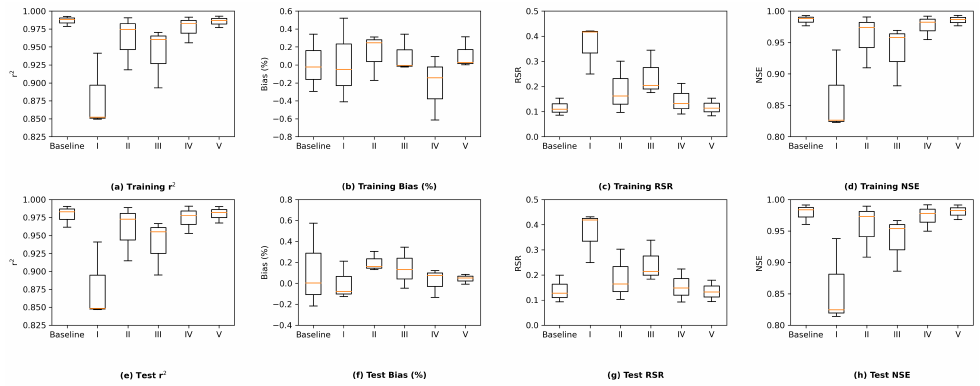
Figure A6. Box and whisker plots of four types of metrics consisting of r 2 , percent bias, RSR, and NSE on stations belonging to the northern Delta group during the training (panels ( a – d )) and test (panels ( e – h )) phases of the grouped MLP model under five scenarios: baseline and four different memory lengths as presented in Table 1.